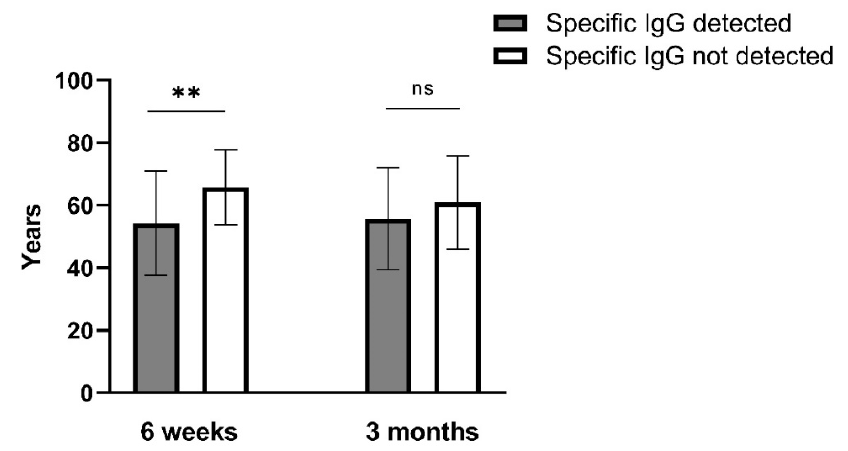
specific IgG antibodies at 6 weeks and 3 months post vaccination. ** p ≤ 0.01; Figure 3. Age (mean ± SD) of BBIBP ‐ CorV recipients according to the presence of SARS ‐ CoV ‐ 2 ‐ spe ‐ cific IgG antibodies at 6 weeks and 3 months post vaccination. ** p ≤ 0.01; ns—non ‐ significant.